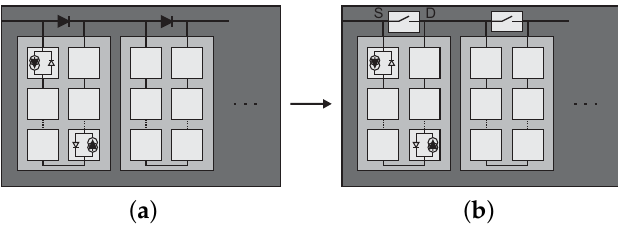
Figure 1. In a solar panel, the traditional bypass diode ( a ) is replaced with a smart bypass with ( b ) a minimal